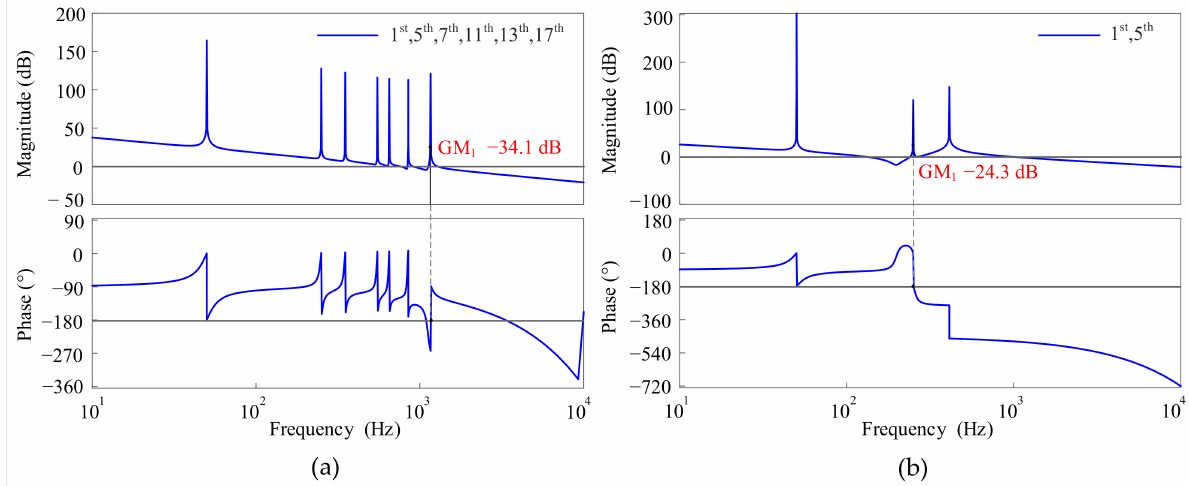
Figure 5. Bode plots of the open-loop transfer function G ol ( s ): ( a ) L g = 0, with the 1st, 5th, 7th, 11th, 13th and 17th resonance controller applied; ( b ) L g = 2.6 mH, with the 1st, 5th resonance controller